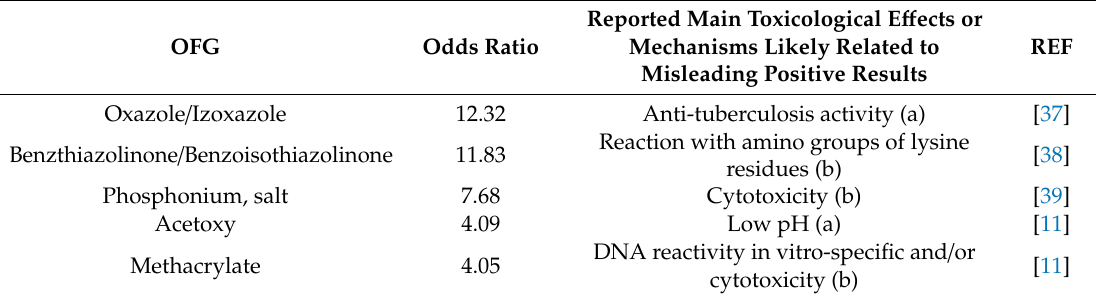
Table 3. OFGs related to misleading positive prediction.